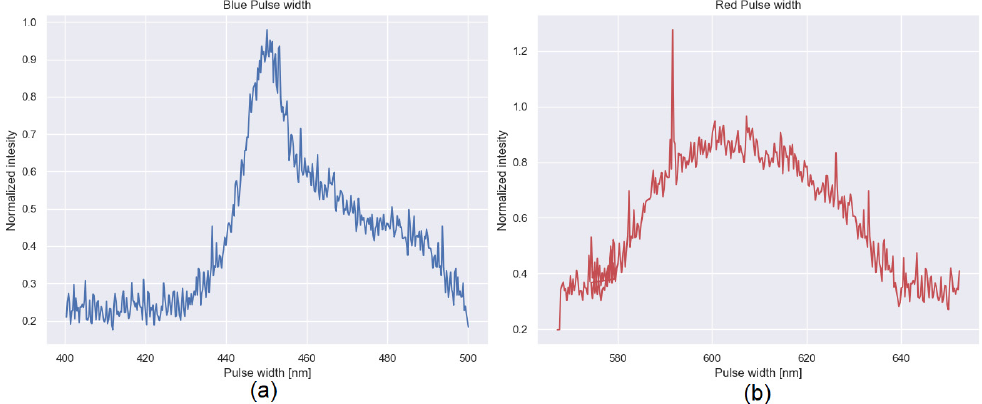
Figure 6. Normalized spectra of LEDs with different pulse widths: ( a ) Blue light source (440-480nm) and ( b ) red light source (580–640 nm).